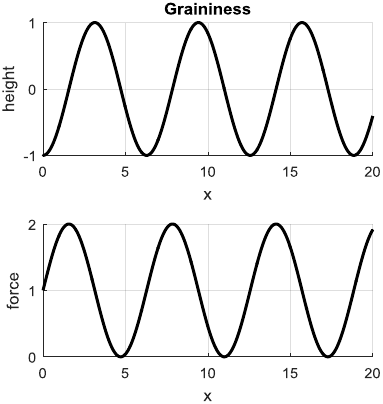
Figure 7. Illustration of the graininess force model.